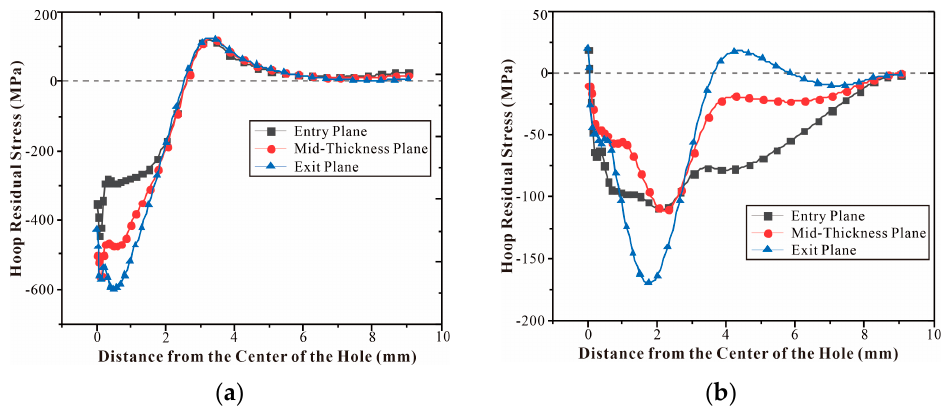
Figure 18. Residual Stress Distribution on the minimum section with the central hole of the single-hole specimen: ( a ) S11/circumferential residual stress distribution; ( b ) S22/Radial residual stress.